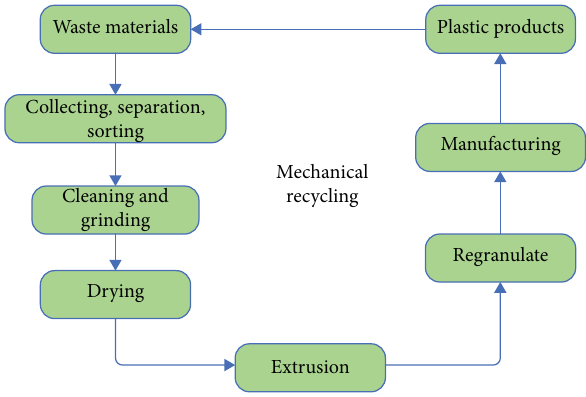
Figure 2: Scheme of mechanical